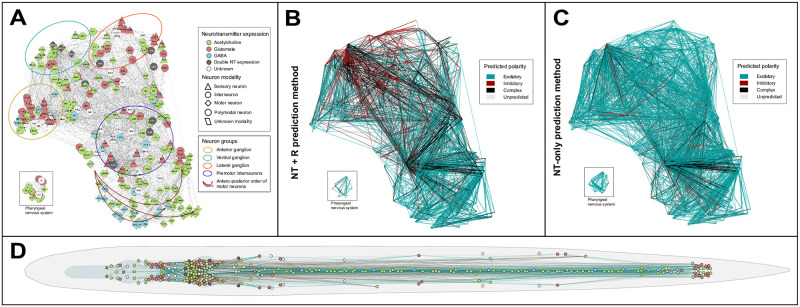
Network representations of the C. elegans chemical synapse network.(A-C) Network representations using the EntOpt layout plugin in Cytoscape [27]. (A) Color and shape of vertices represent neurotransmitter expression and modality of neurons, respectively (see inset for definitions). (B) Edges represent excitatory (blue), inhibitory (red), or complex (black) chemical connections predicted by the NT+R method (see Methods), weighted according to synapse numbers. (C) Colors of edges (see panel B) represent the polarities of chemical synapses predicted by the NT-only method. (D) Layout of vertices is representing the anatomic position of neurons. Node and edge colors are as in panels A and B, respectively. High-resolution representation is available in S1 File.